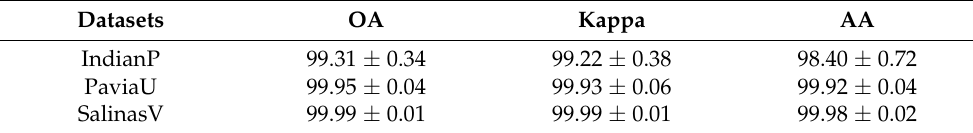
Table 2. The classification accuracy of LRCNet repeated experiments on three datasets (%).